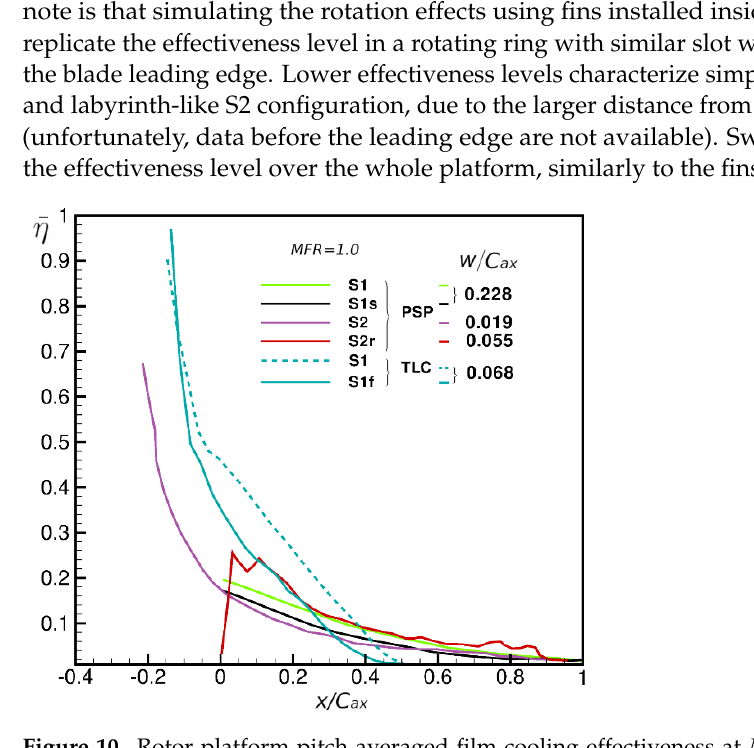
Figure 10. Rotor platform pitch averaged film cooling effectiveness at MFR = 1.0% for different cooling slot configurations: S2r at design rotational speed [29], S1 and S1f with − 10 ◦ fins [22], S1 and S1s with SR = 0.4 [17], S2 with simulated stator effect [20].